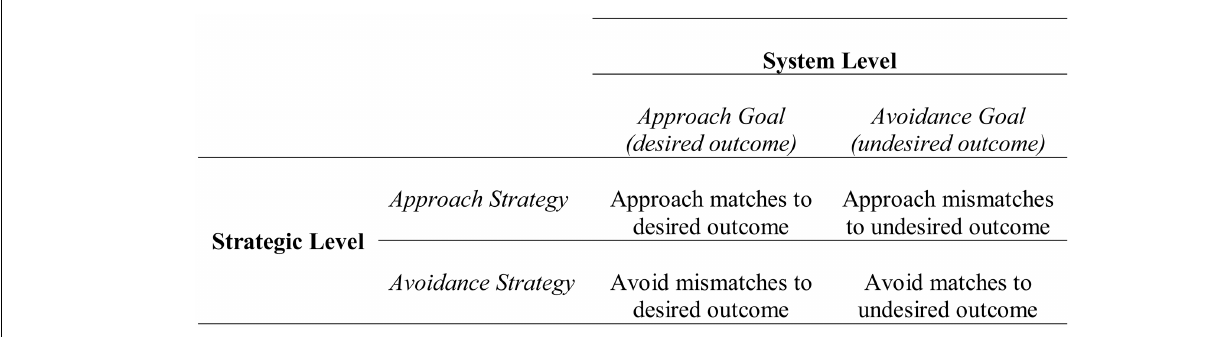
with the desired state) or matches to an undesirable outcome